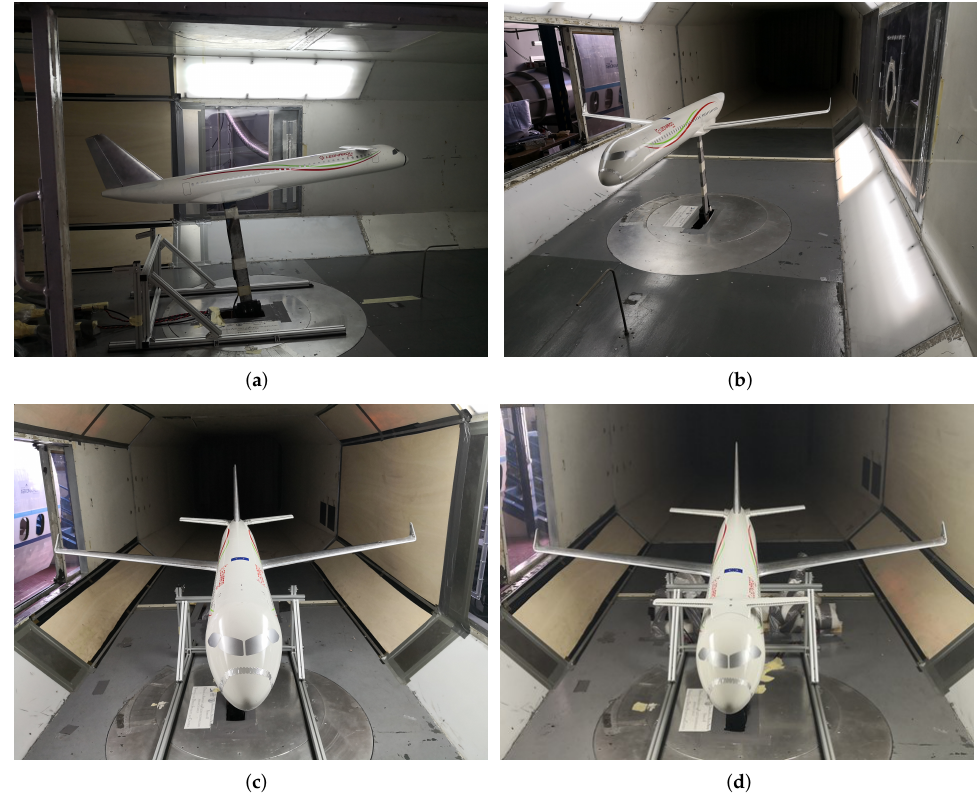
Figure 12. Some of aircraft configurations tested in the wind tunnel. ( a ) BCV configuration; ( b ) WB configuration; ( c ) WBHV configuration; and ( d ) WBHCV